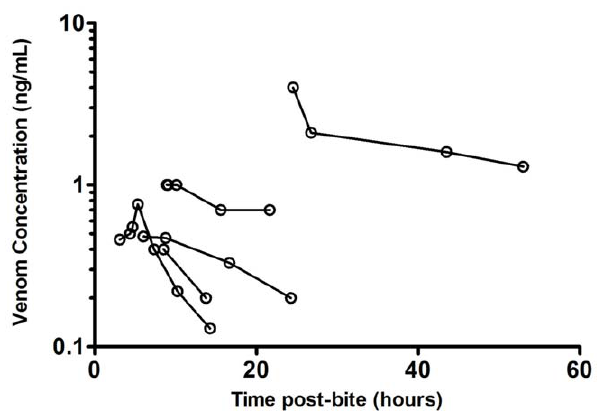
Figure 6. Plots of venom concentration versus time in five of the eight patients who were not given antivenom.